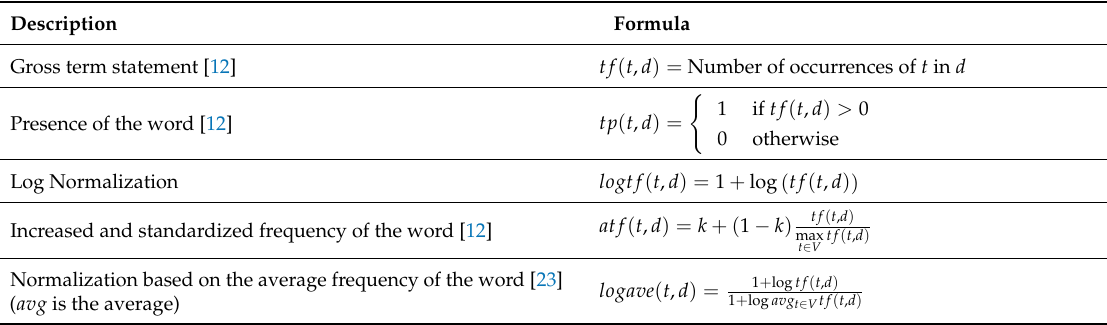
Table 6. Local weighting